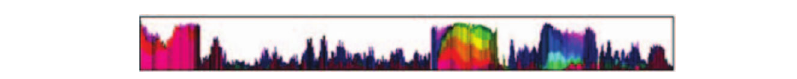
Fig. 4 Histograms of motion with HSV color space. Extracted from